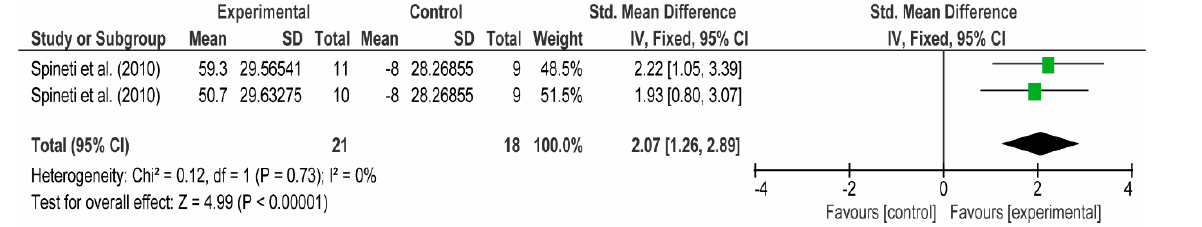
Figure 12. The effect size of 12-weeks of nonlinear periodised resistance training on increasing the triceps brachii MV. The lines for Spineti et al. [89] respectively represent nonlinear periodised large to small muscle training and small to large muscle training groups.